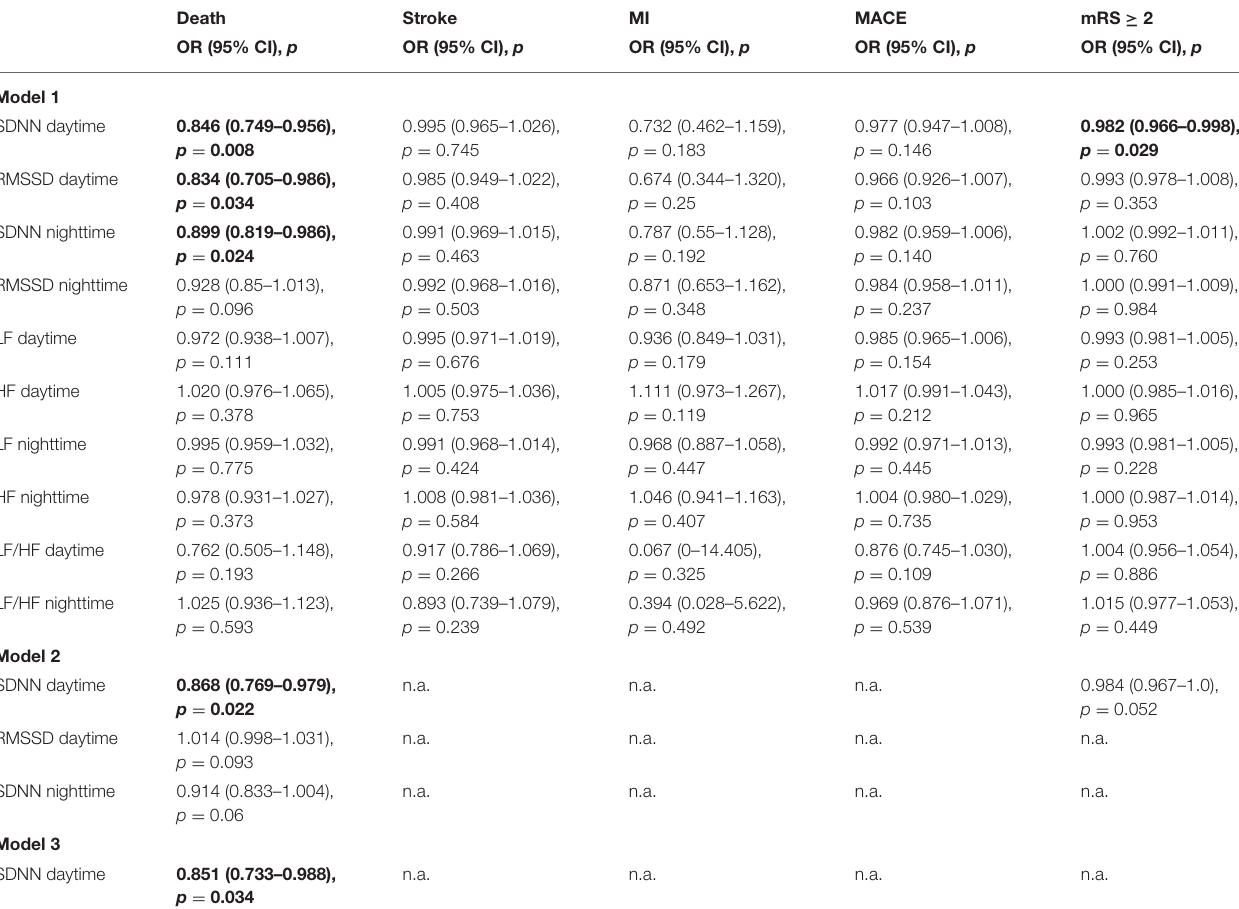
TABLE 2 | HRV and outcome at 90